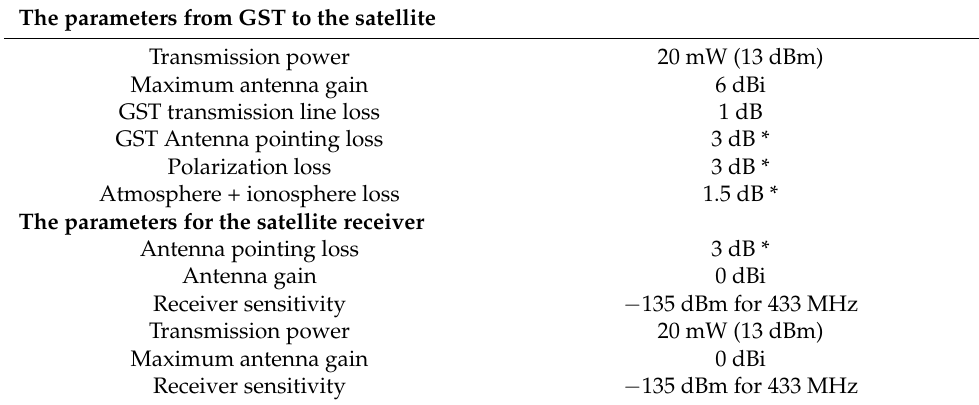
Table 4. The parameters used for the link budget calculation. The parameters from GST to the satellite